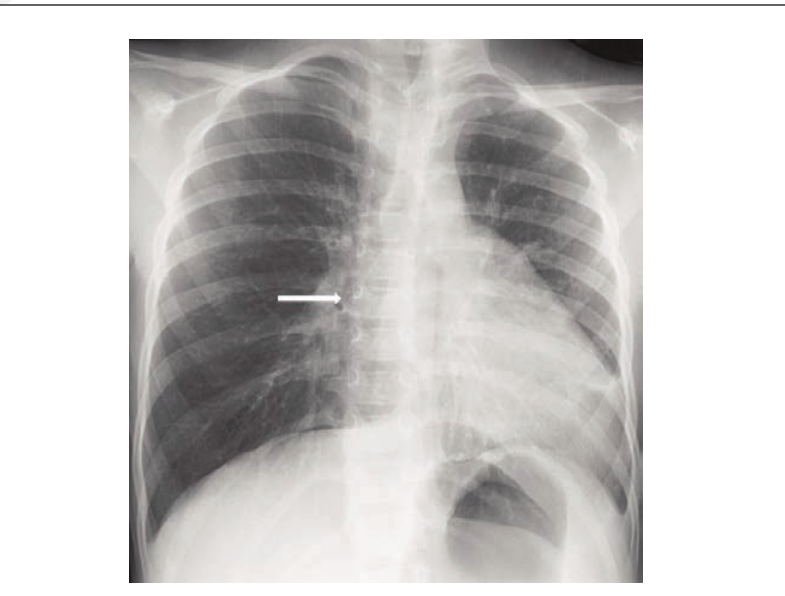
Figure 3. Chest X-Ray, frontal view. It documents the leftward shift of the heart and the loss of the right cardiac border